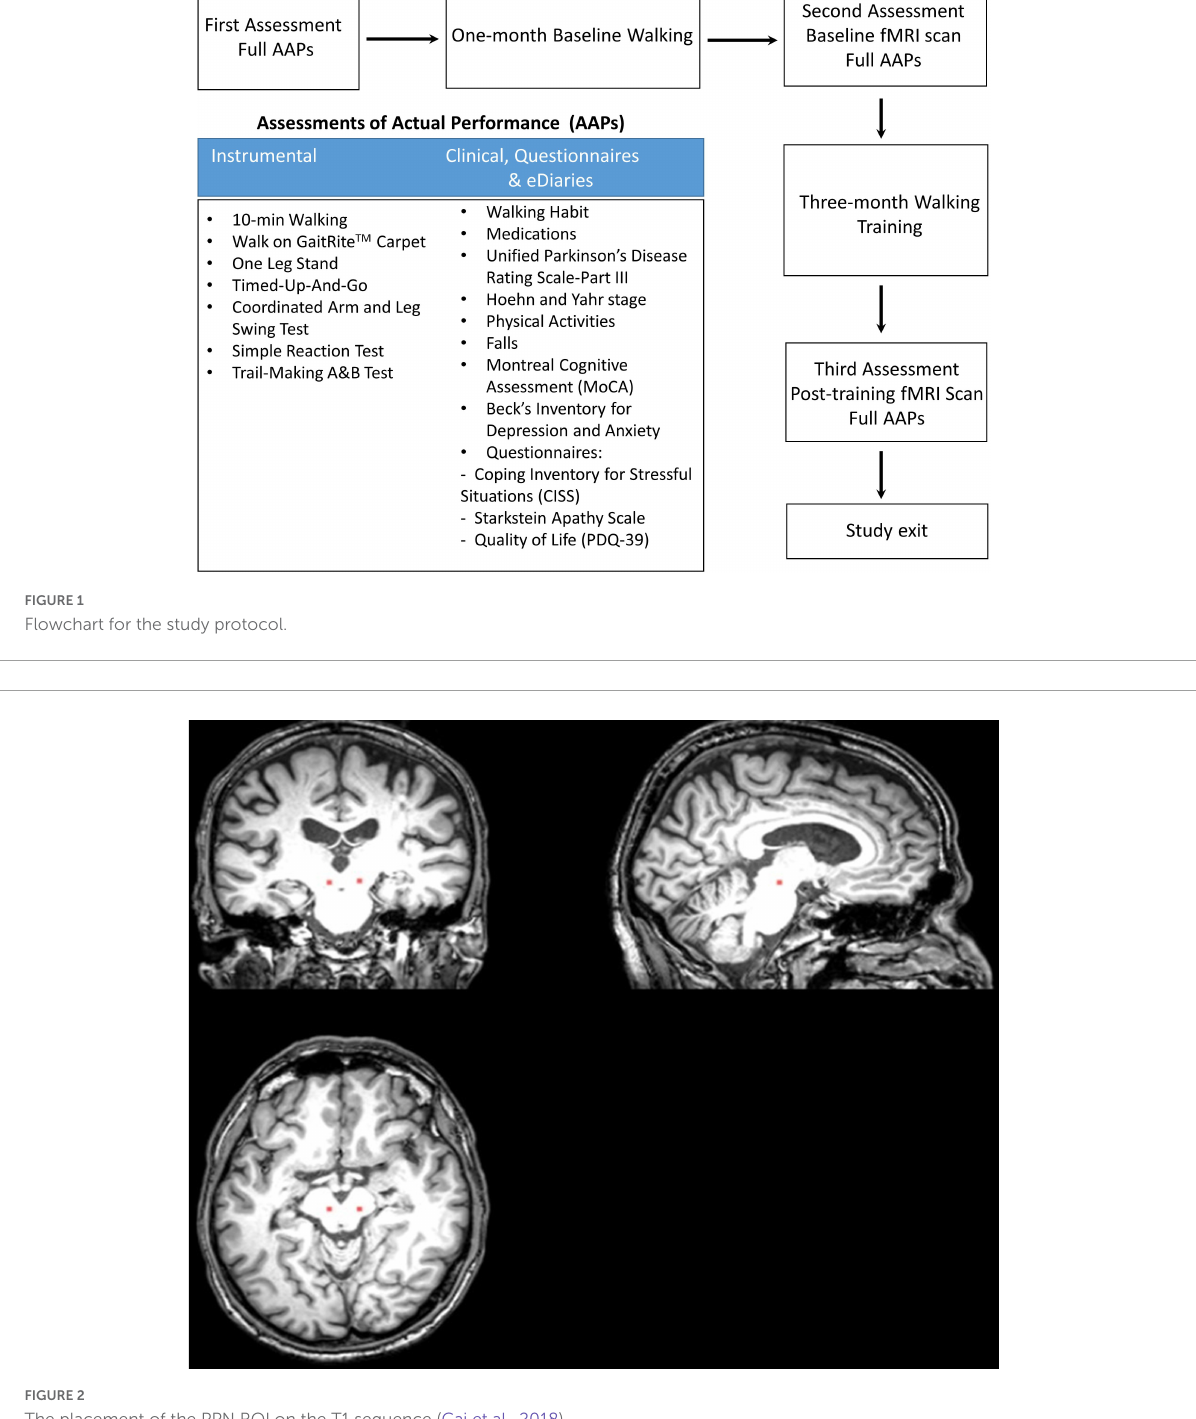
cuneiform nucleus ( Figure 2 ). BOLD contrast T2 ∗ -weighted images were obtained using a gradient-echo EPI sequence with the repetition time of 1,985 ms, echo time of 37 ms, flip angle